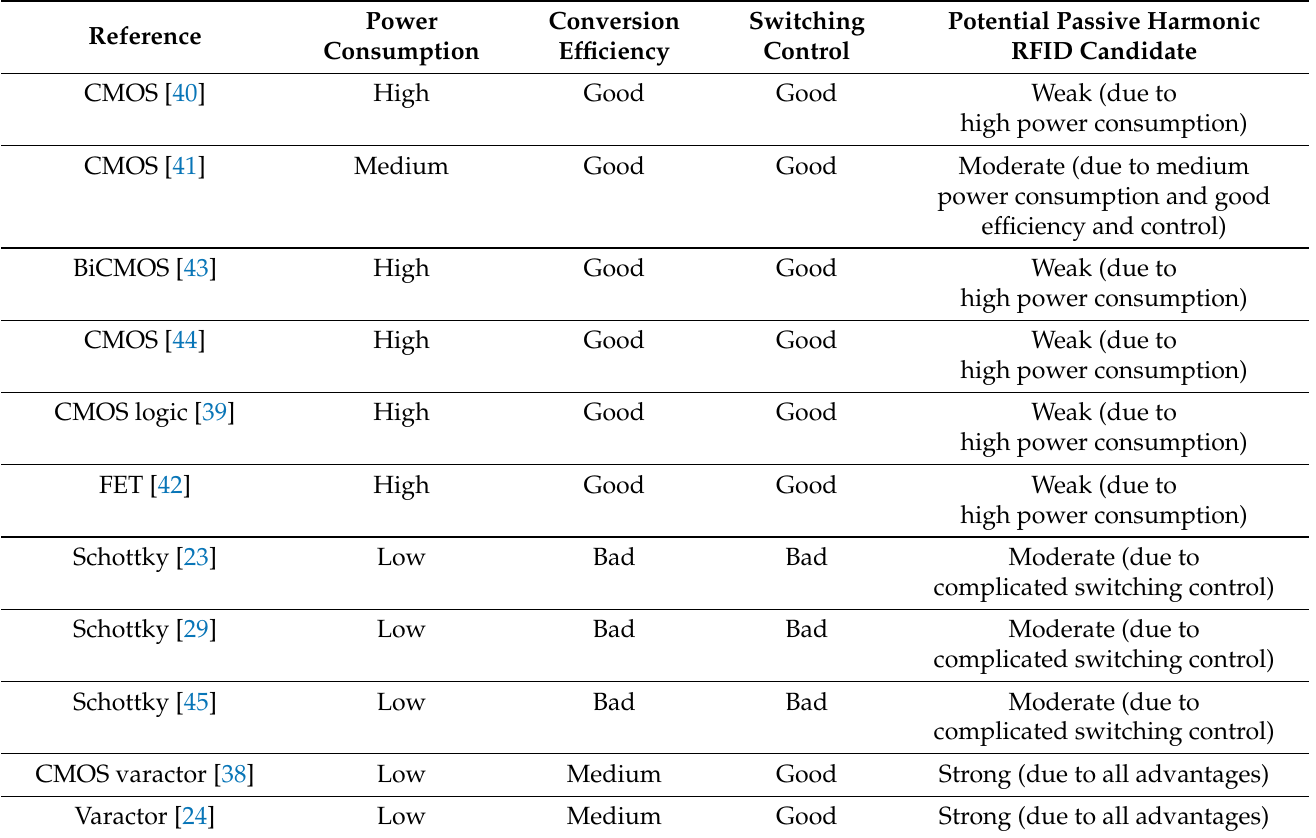
Table 3. Comparison of different multipliers for potential passive harmonic RFID